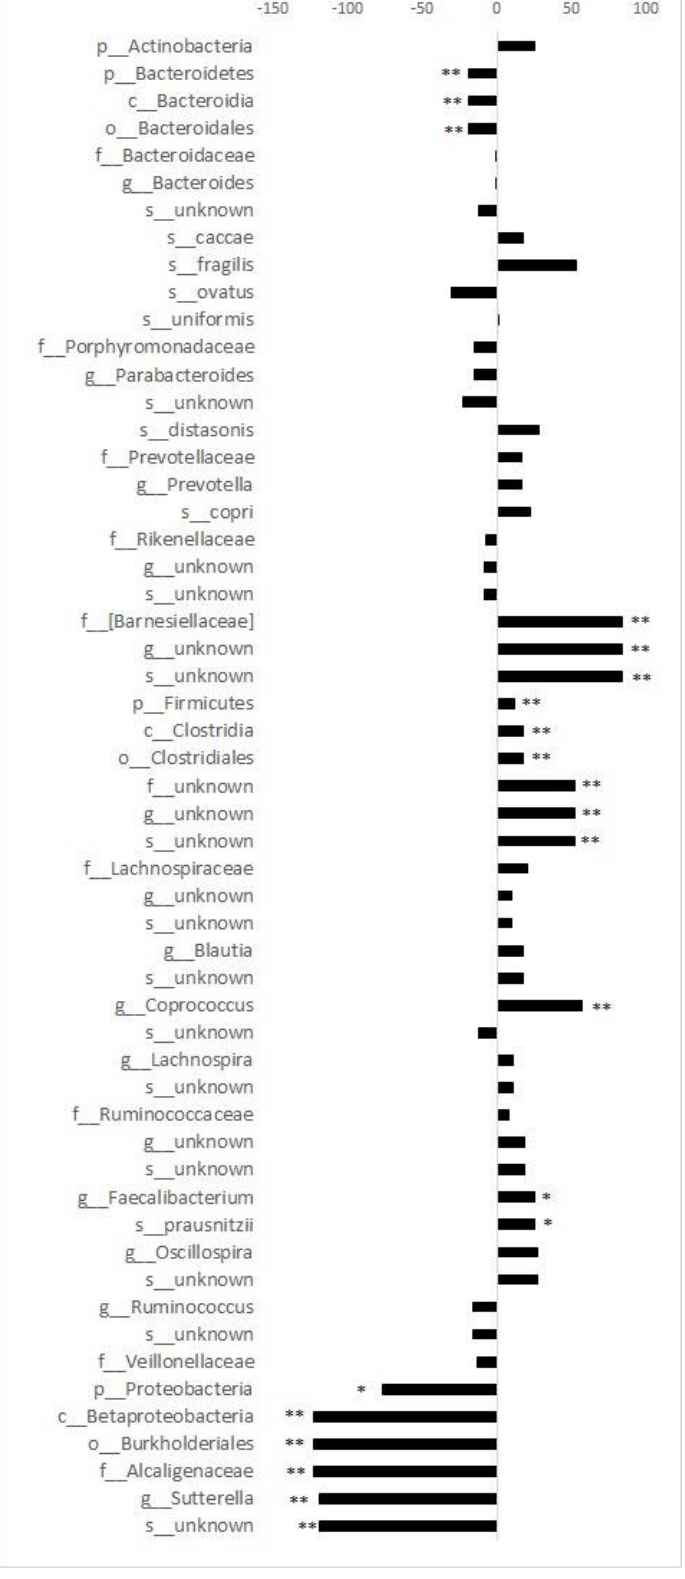
Figure 3. Differences in relative abundance between the highest and the lowest IDQ score quartiles. * FDR < 0.2, ** FDR < 0.1. The p -values for the differences were corrected for multiple testing. The false discovery rate (FDR) was 0.2 *, but also those with FDR < 0.1 are shown **. The values represent a median difference as percentage and confidence interval (95% CI).